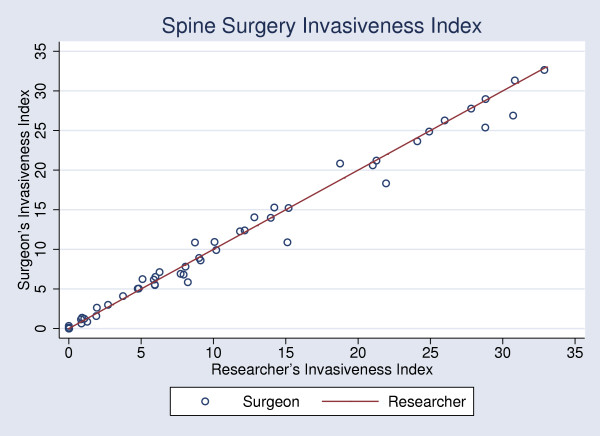
Spine Surgery Invasiveness Index. Spine Surgery Invasiveness Index assigned by the treating surgeon and two researchers for 50 consecutive operations.